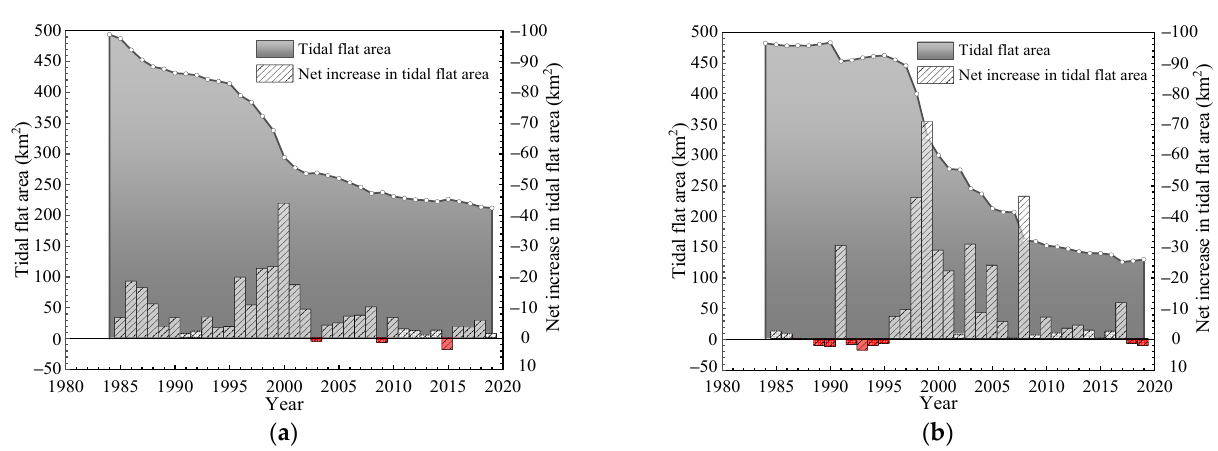
Figure 9. ( a ) The variation tendency of natural tidal flat area in the north erosion part; ( b ) The variation tendency of natural tidal flat area in the south deposition part.